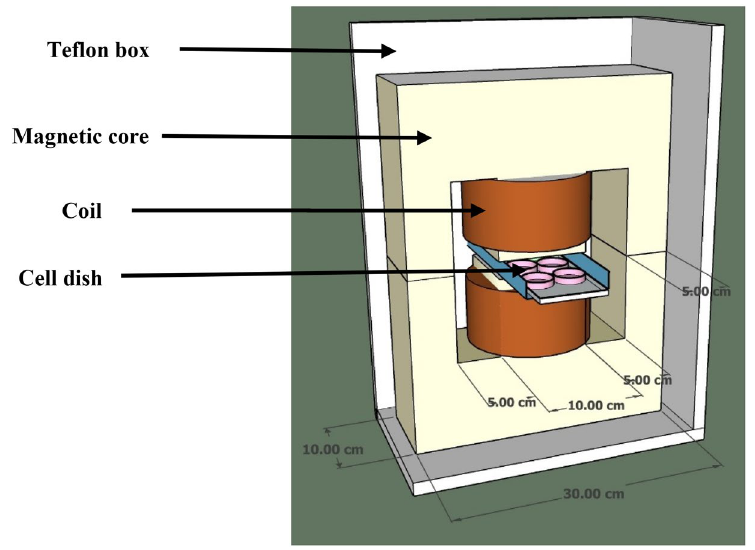
Figure 2. Internal schematic diagram of ELF-EMF exposure system.